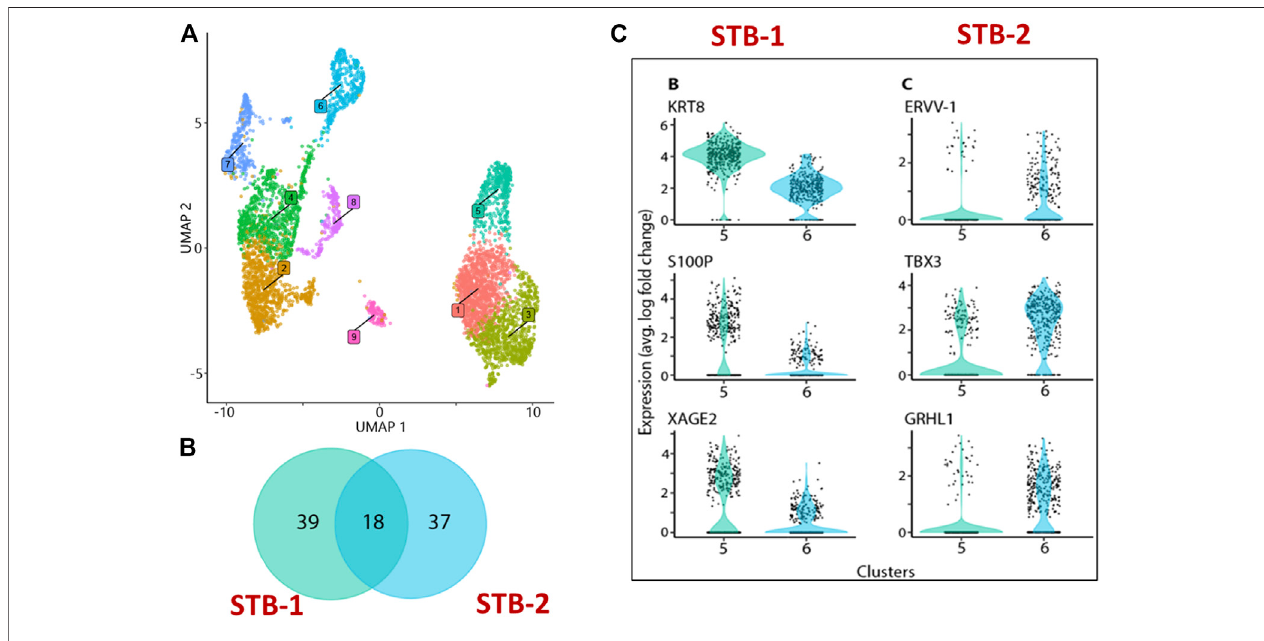
FIGURE 3 | snRNA-seq from BAP directed TB. (A) Visualization of nuclei included in the analysis, colored according to assignment by clustering analysis. Five clusters: 1,4, 7, 8, and 9 were different kinds of CTBs, cluster 2 and 3were EVT-like, and clusters 5 and 6 showed strong resemblance tohuman fi rst trimester STB. (B) DetailsofdifferentiallyupregulatedSTBgenesbetweenSTB-1andSTB-2. (C) RepresentativeSTBdifferentiallyupregulatedgenesshowingexpressionacrossthenuclei from STB-1 (left panel) and STB-2 (right panel). STB-1 and STB-2 referring cluster 5 and 6 respectively from cluster analysis of snRNA-seq ( Figure 3A ). Reproduced with permission from Khan et al. (Khan et al., 2021). TB, trophoblast; EVT, extra villous trophoblast cells; CTB, cytotrophoblast cells; STB,